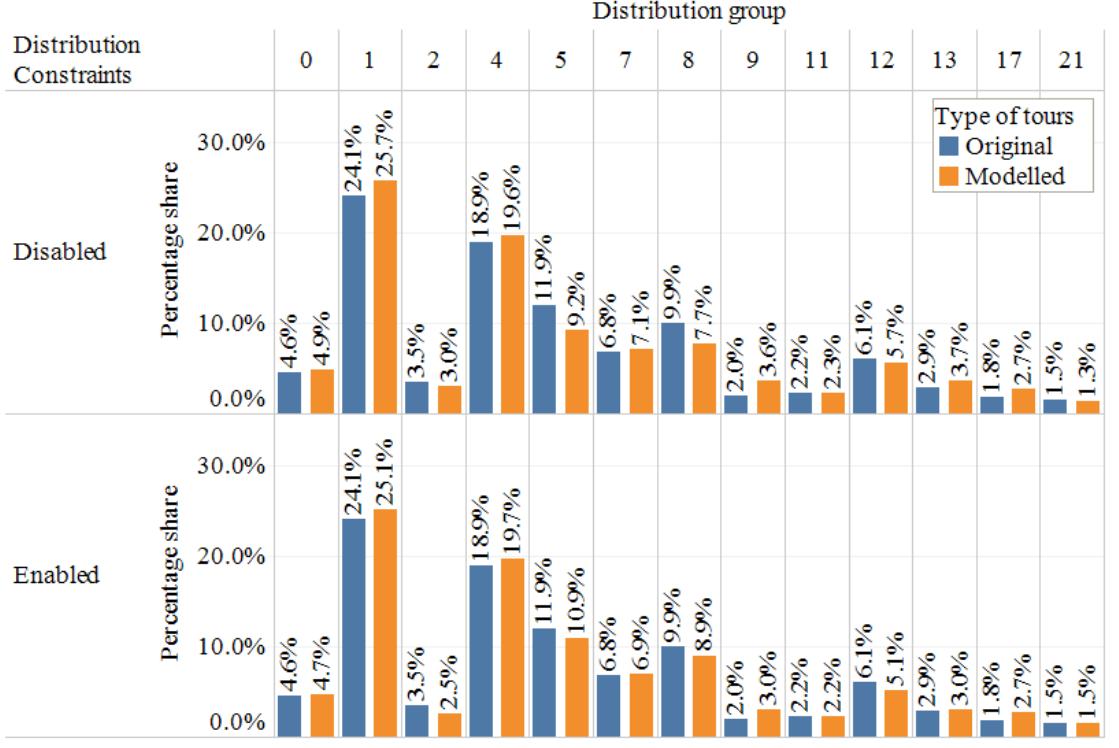
Figure 7. Comparison of distributions between original and modelled tours with a share greater than 1%. (Scenarios